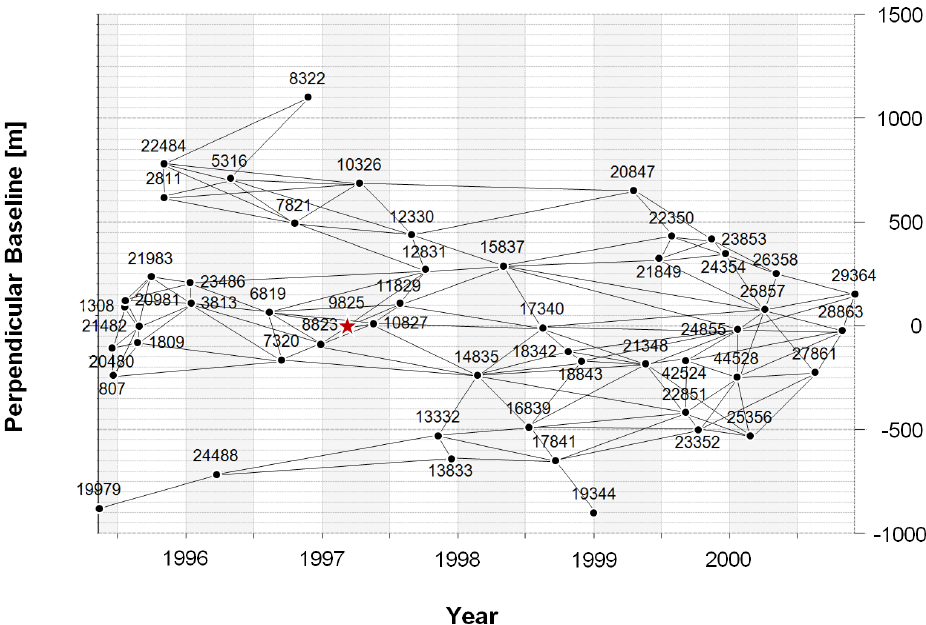
Fig. 5. Temporal vs. spatial baseline distributions for the interferometric stack used in this study (black circles). The reference scene used in the PS processing is indicated by the star. The small baseline interferograms represented by the continuous black lines and used in the SB processing were computed with minimum coherence of 0.6, maximal spatial baseline of 350m and maximal temporal baseline of 700days. Figure generated by viStaMPS (Sousa et al.,